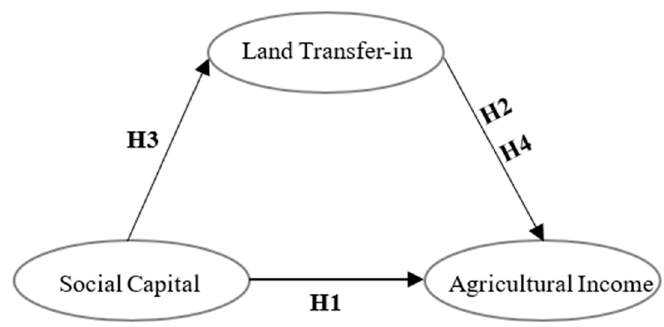
Figure 1. Hypothesized conceptual model.